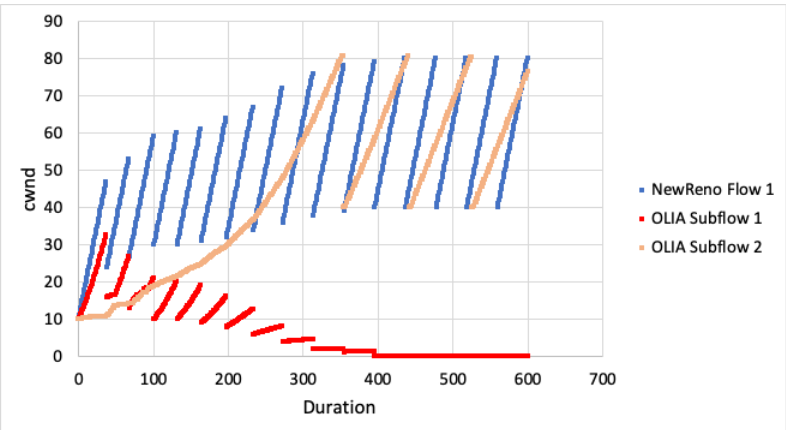
Figure 13. OLIA—Competing Window Growth— Subflow 1 RTT = x , Subflow 2 RTT = 2 x .